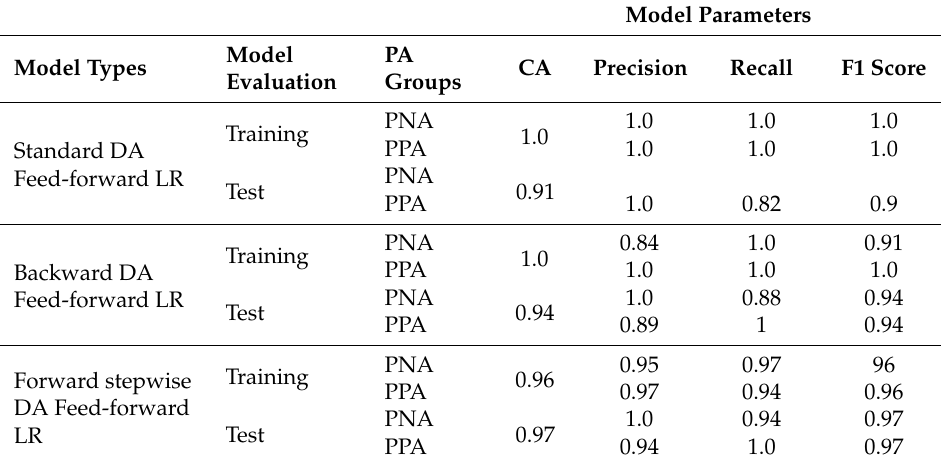
Table 5. The Logistic Regression Model for the PA Smoker